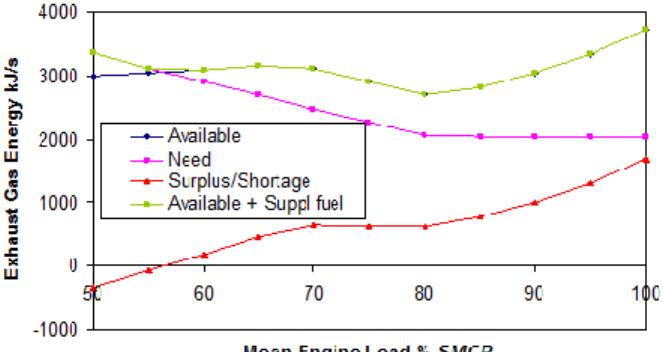
Figure 10. Exhaust gas energy and supplemental HFO energy at standard electrical power and heat for the R123